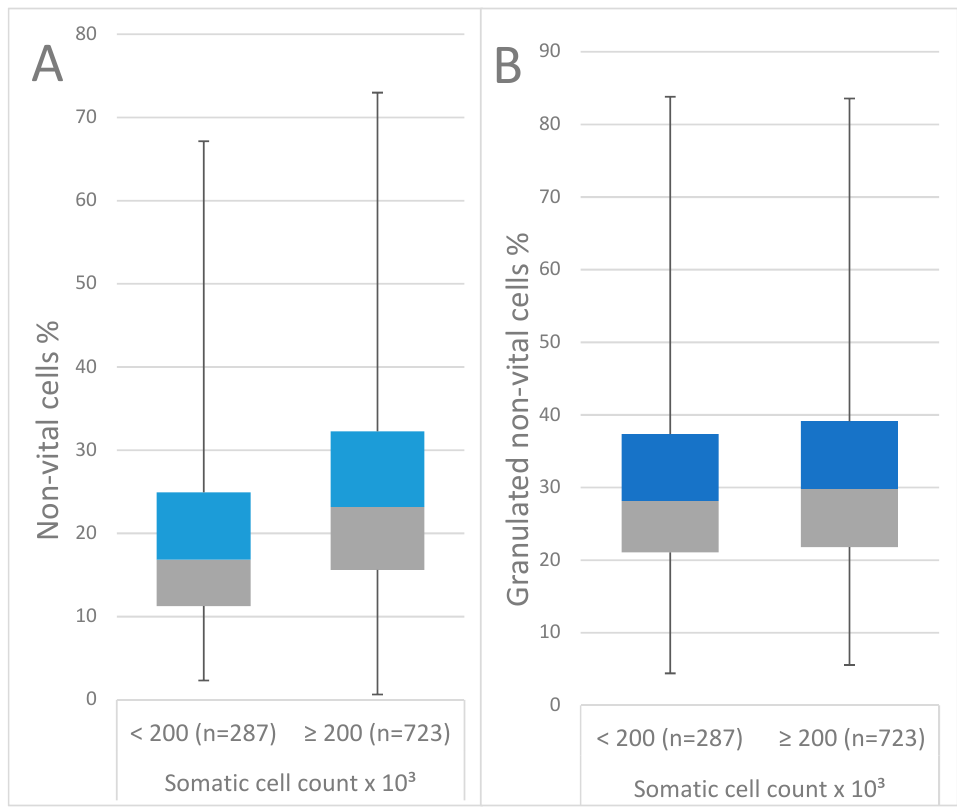
Figure 2. Box and whiskers plot of flow cytometric results of composite milk samples associated with the individual cytological cure: ( A ) percentage of total non-vital cells and ( B ) percentage of highly granulated non-vital